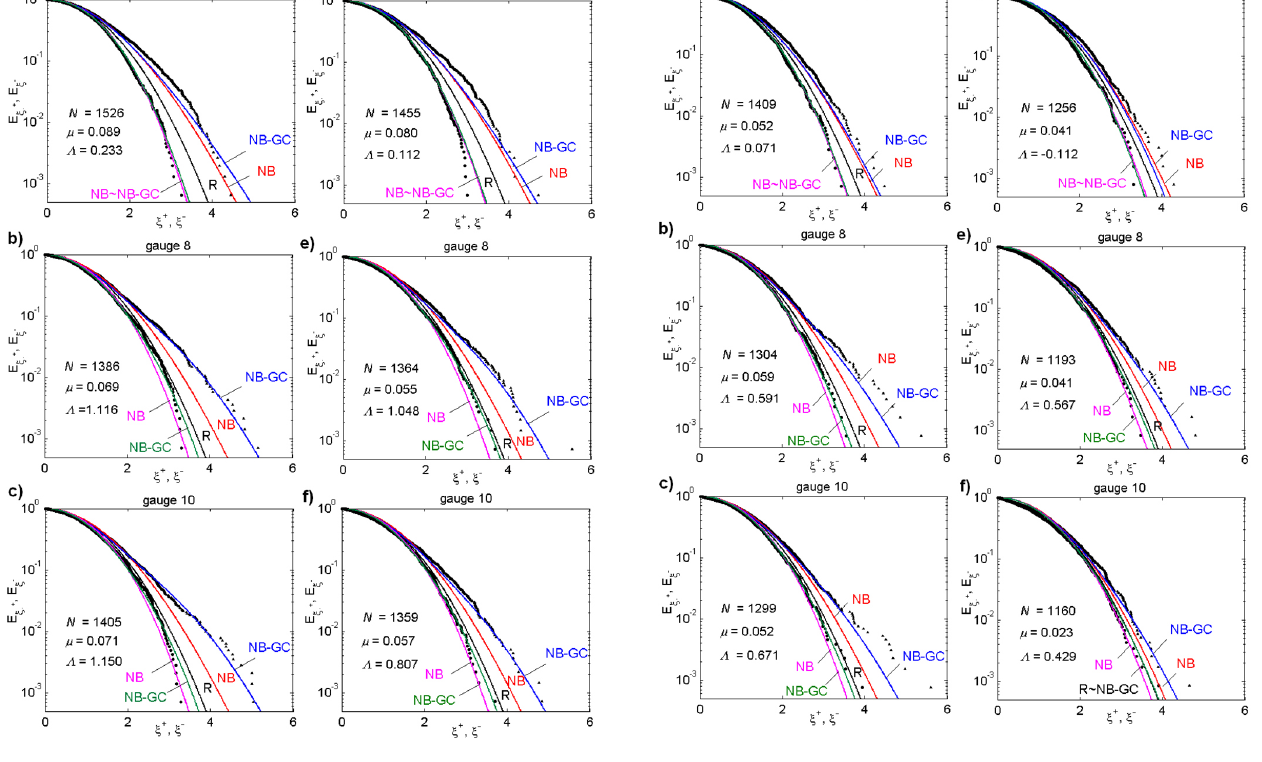
Figure 8. Exceedance distributions of wave crests and troughs along the tank for (a–c) test 8228 and (d–f) test 8229.